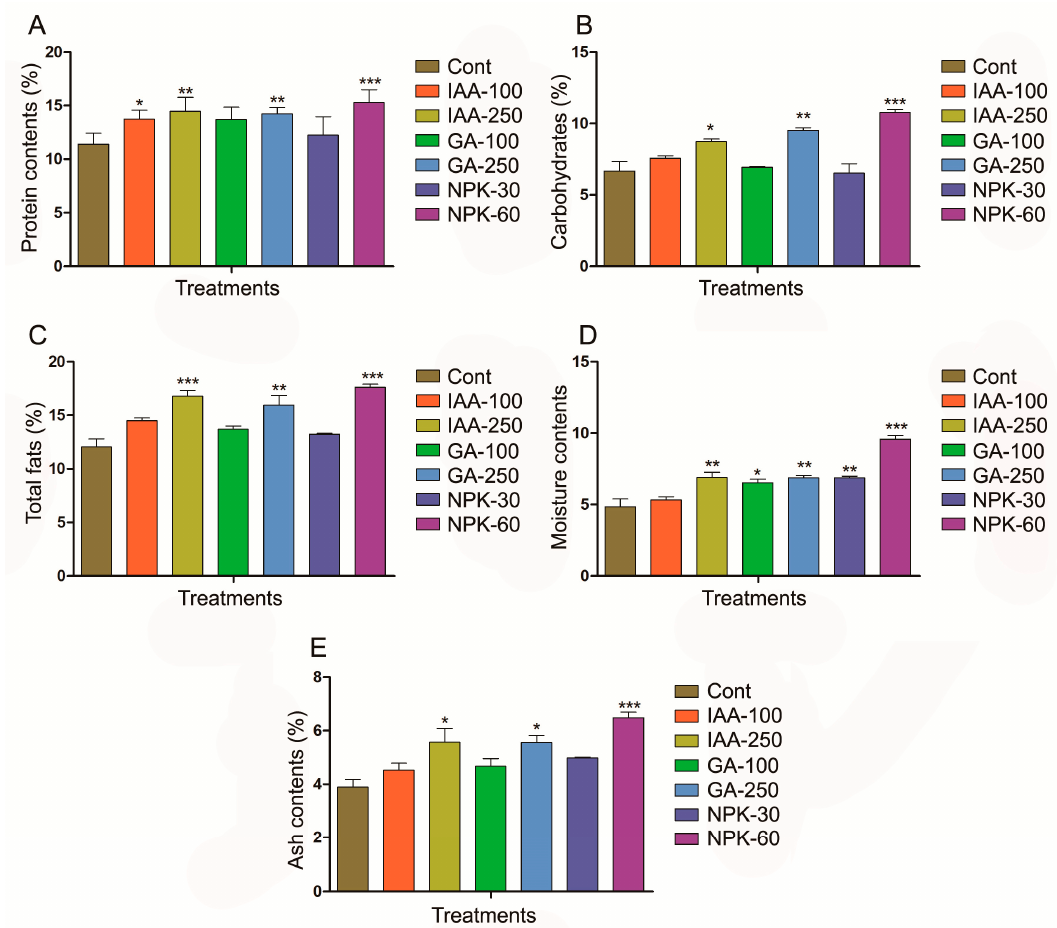
Figure 3. IAA, GA, and NPK induces biosynthesis of J. curcas plant proximate composition contents. ( A ) represents protein contents, ( B ) represents carbohydrate contents, ( C ) represents fat contents, ( D ) represents moisture contents, and ( E ) represents ash contents. Graphs show mean ± standard deviation, and asterisks show significant differences (* p ≤ 0.05, ** p ≤ 0.01, and *** p ≤ 0.001) according to two-way ANOVA and Bonferroni post hoc tests.